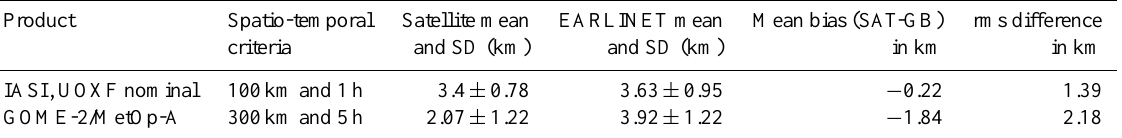
Table 5. Statistical mean values and associated standard deviation (SD) for the EARLINET and the satellite ash plume height estimates.